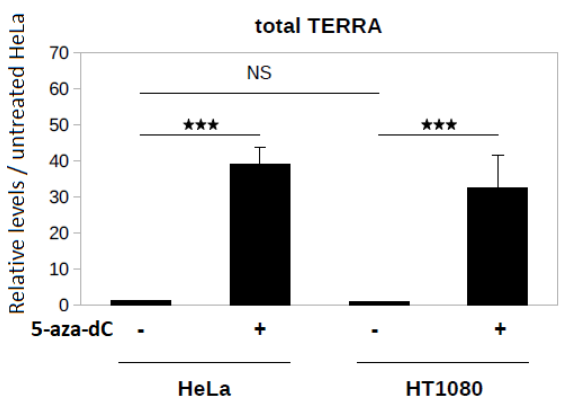
Figure 4. Application of AP-TSS to TERRA extracted from HeLa and HT1080 cells. ( A ) Measure of the level of TSSi TERRA by AP-TSS. RNA from HeLa and HT1080 cells untreated or treated with 5-aza-dC was reverse transcribed using RP-TERRA as a primer. Elongation was carried out using OT. TERRA produced from the TSSi located on subtelomeres Xq, Yq, 15q, and 9p was specifically quantified by qPCR using P1 and P-TERRA primers; levels were normalized to GAPDH RNA, and all values were compared to untreated HeLa sample. ( B ) Measure of the level of total TERRA by classical qPCR. RNA from HeLa and HT1080 cells untreated or treated with 5-aza-dC was reverse transcribed using RP-TERRA as a primer. TERRA from subtelomeres Xq, Yq, 15q, and 9p (total TERRA) was quantified by qPCR using TR and TF primers; levels were normalized to GAPDH RNA, and all values were compared to untreated HeLa sample. The bars represent the average values from three biological and two technical replicates for each sample. Error bars represent the standard deviations. P-values were calculated by paired two-tailed Student t-test ( n = 3). NS, not significant, * p < 0.05, ** p < 0.01, *** p < 0.001.